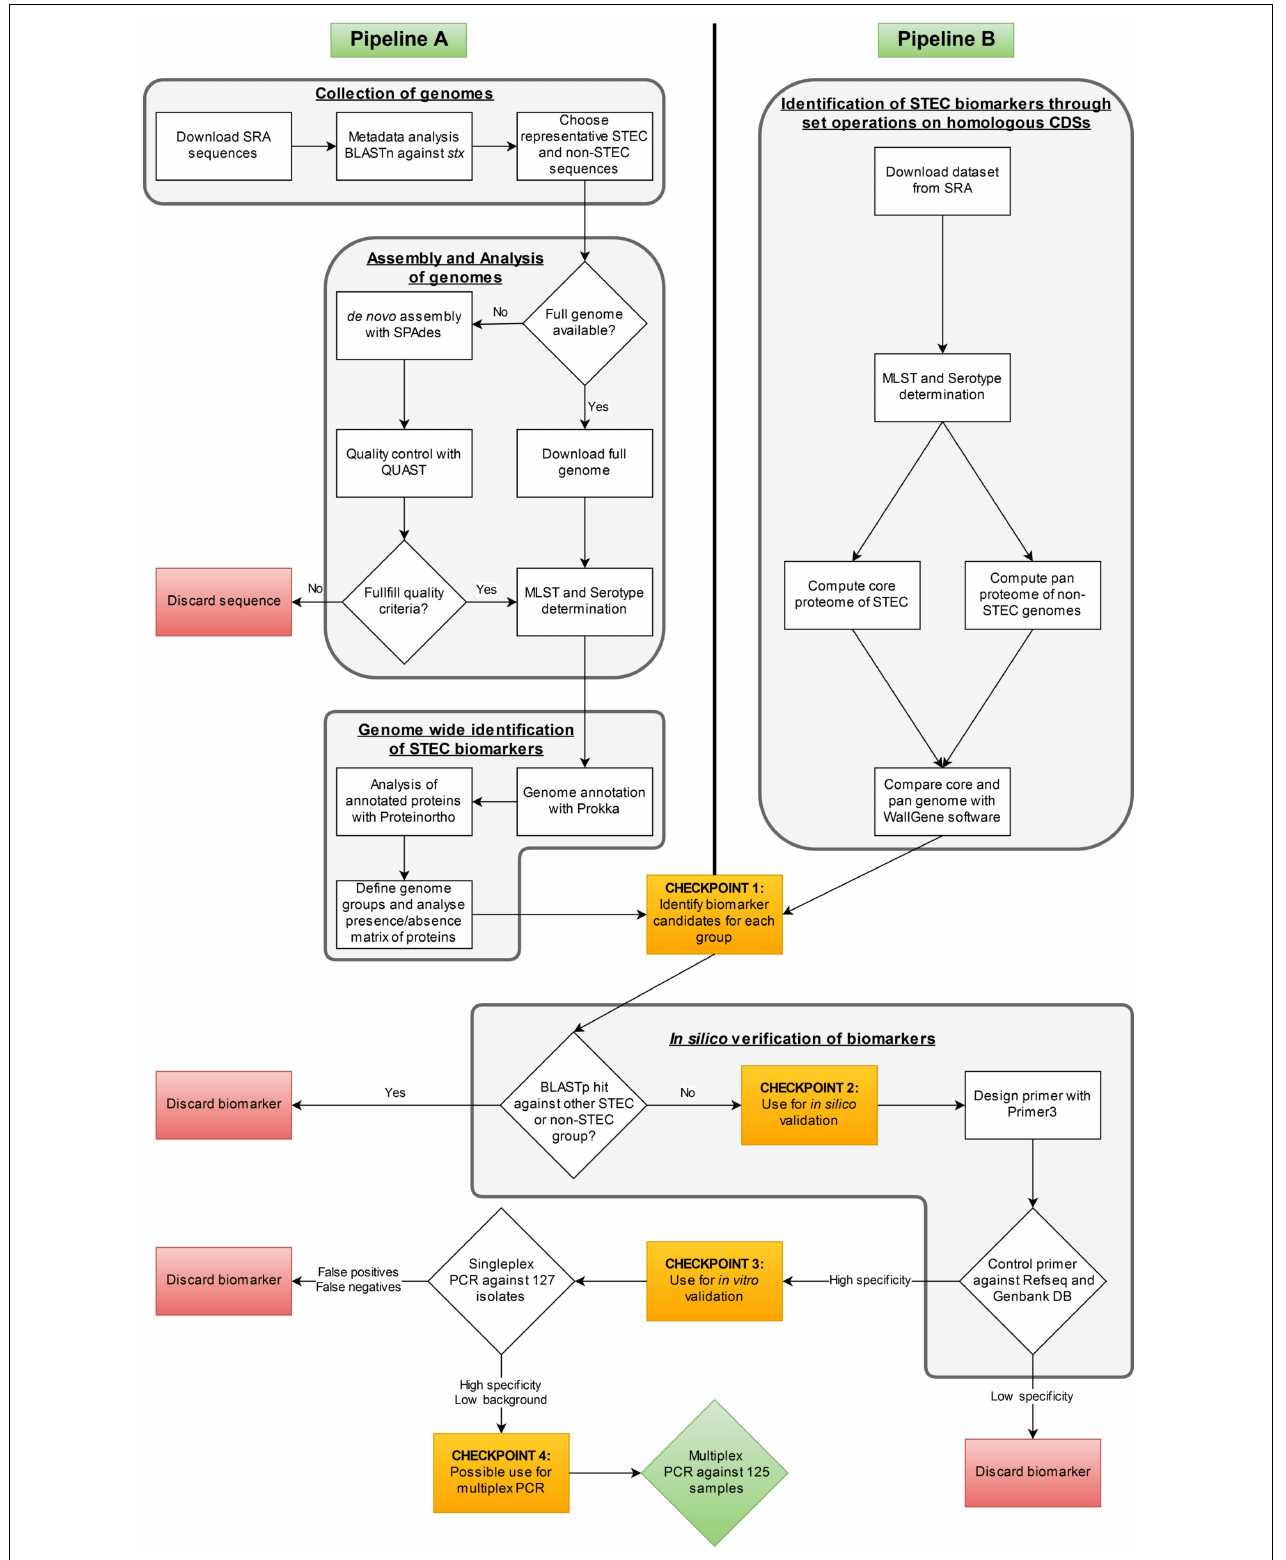
FIGURE 1 | Workflow of the comparative genomic analyses applied in this study for STEC biomarker identification.